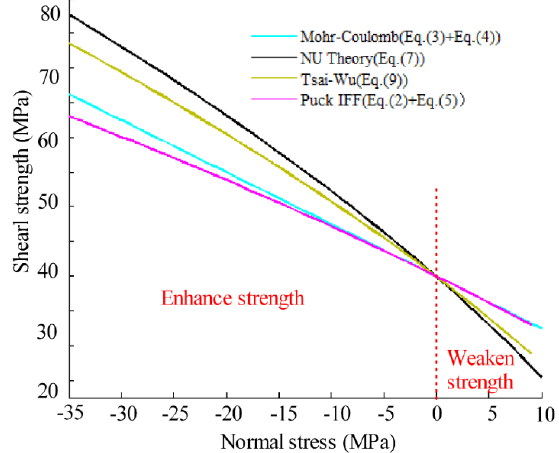
Figure 15: Relationship between normal stress and interlaminar shear strength under different failure criteria